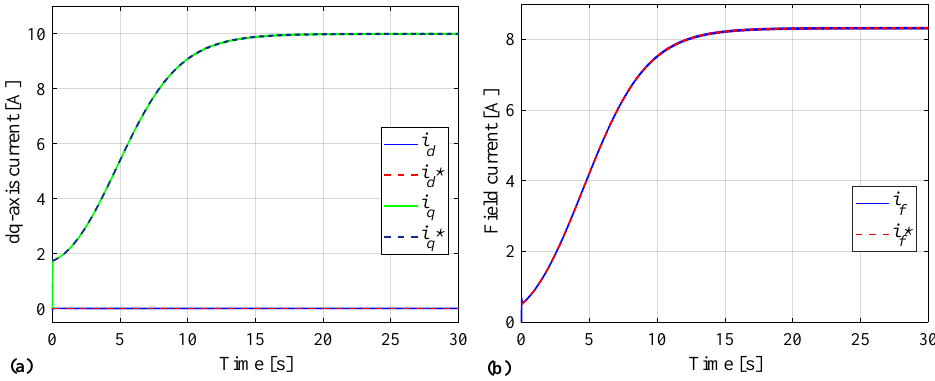
Figure 19. ( a ) dq -axis and ( b ) field currents for wind speed input of 10 Hz versus